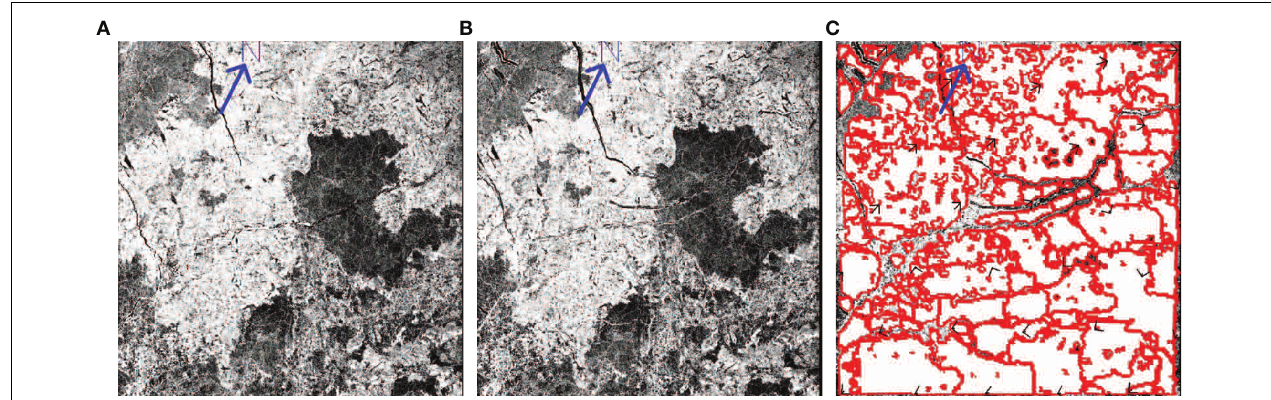
FIGURE 1 | Panels (A,B) show two successive SAR radar images taken over the Kara sea on January 28th and 31st 1994. Panel (C) shows the identifies ice floes using the method described in Korsens et al.